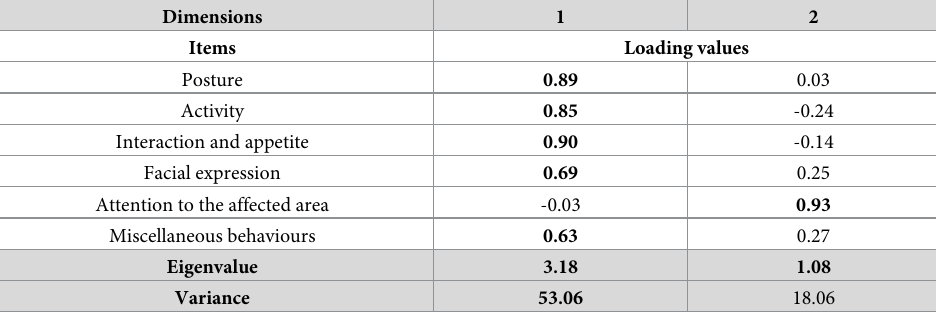
The structure was determined considering items with a loading value � 0.50 or � -0.50 with representative dimension (eigenvalue > 1 and variance > 20%). The loading values in bold indicate the variables that contribute